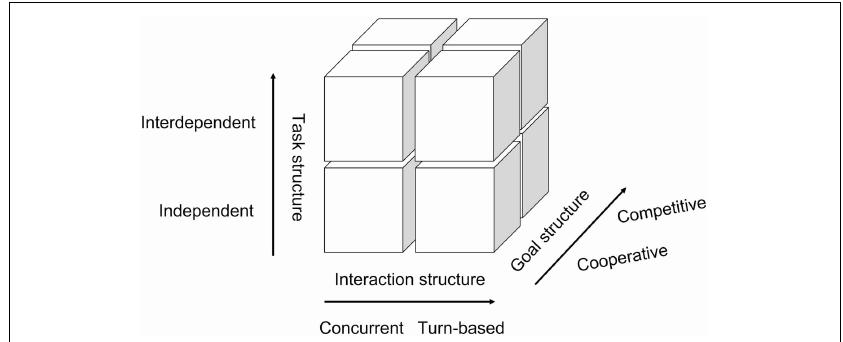
FIGURE 1 | Potential interaction structures in hyperscanning